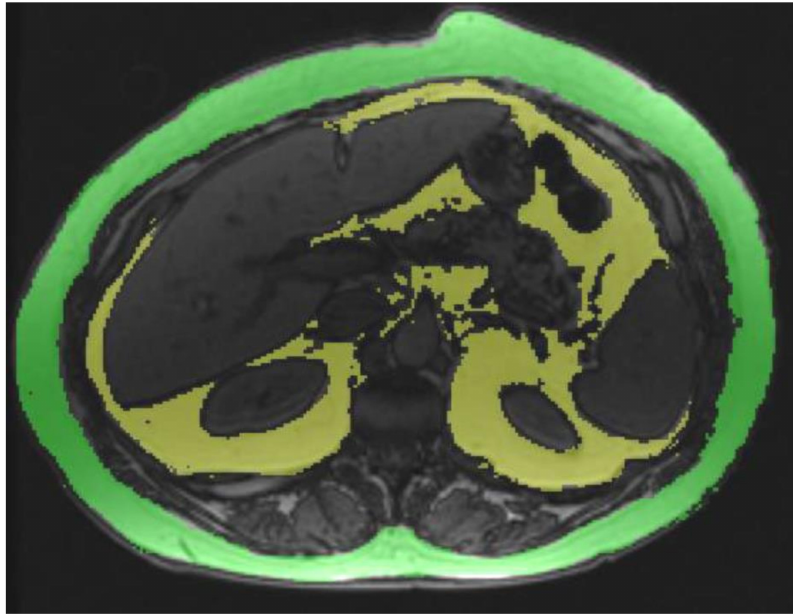
Figure 1. VAT area quantification at L2-L3 level on opposed-phase images using a semi-quantitative software (RIL